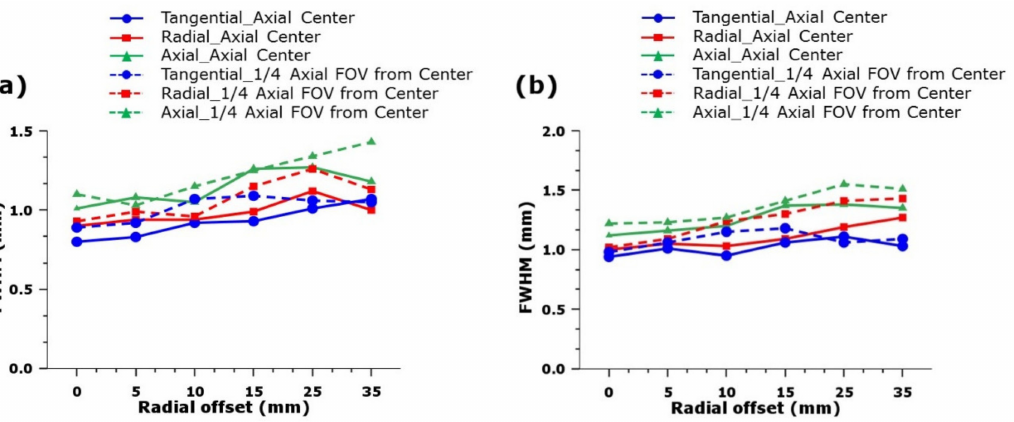
Figure 3. ( a ) FWHM of the 3D-MLEM-reconstructed images and ( b ) FWHM of the FBP- reconstructed images.